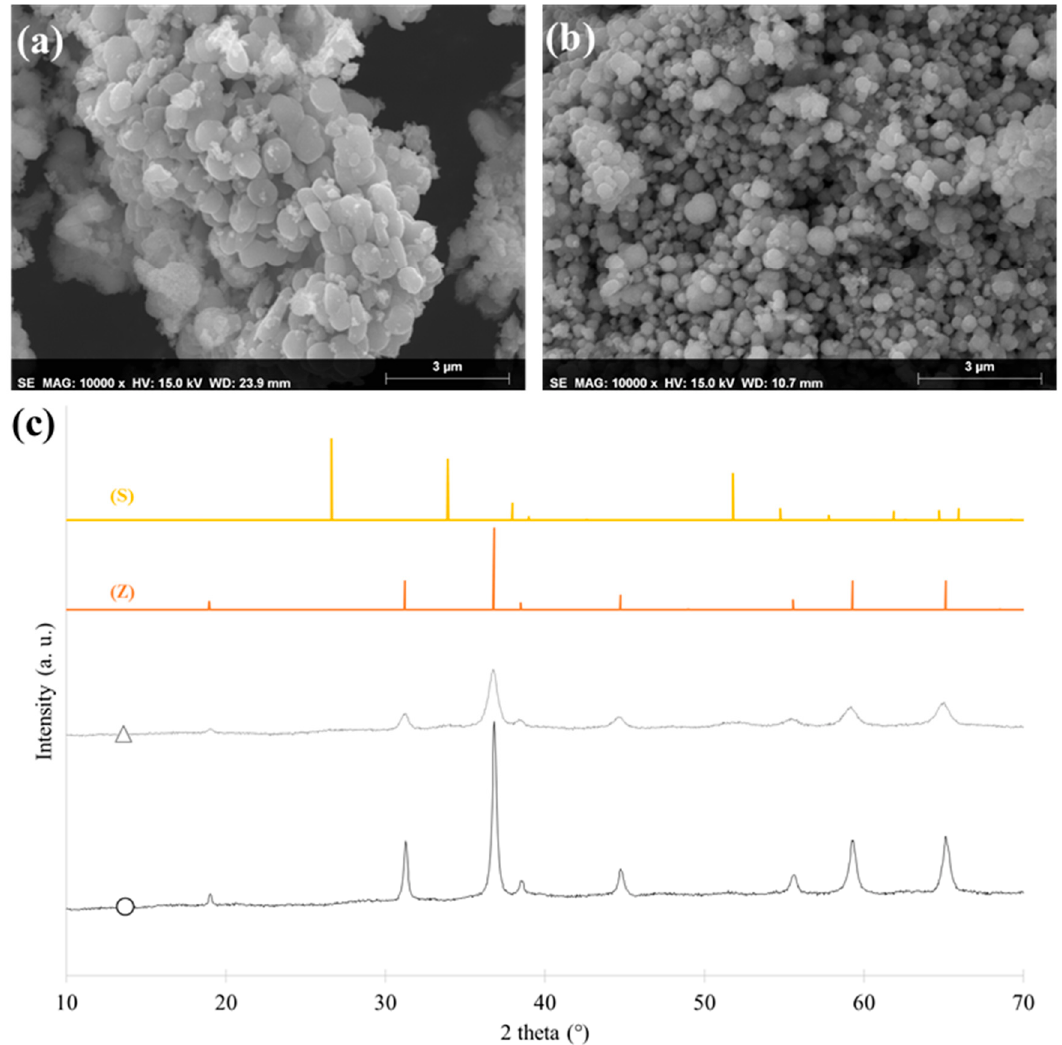
Figure 13. SEM images of pure ZnCo 2 O 4 ( a ) and ZnCo 2 O 4 / SnO 2 -20% ( b ) samples after the four recycling cycles. ( c ) XRD patterns of ( ○ ) pure ZnCo 2 O 4 and ( ∆ ) ZnCo 2 O 4 /SnO 2 -20% after the four recycling cycles. (Z) Reference pattern of cubic spinel ZnCo2O4 and (S) reference pattern of tetragonal rutile SnO 2 .